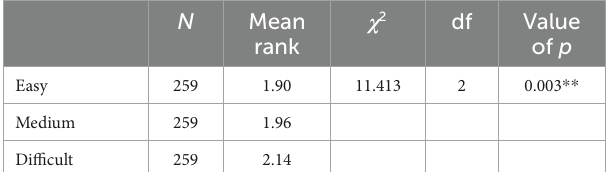
TABLE 5 Friedman test.